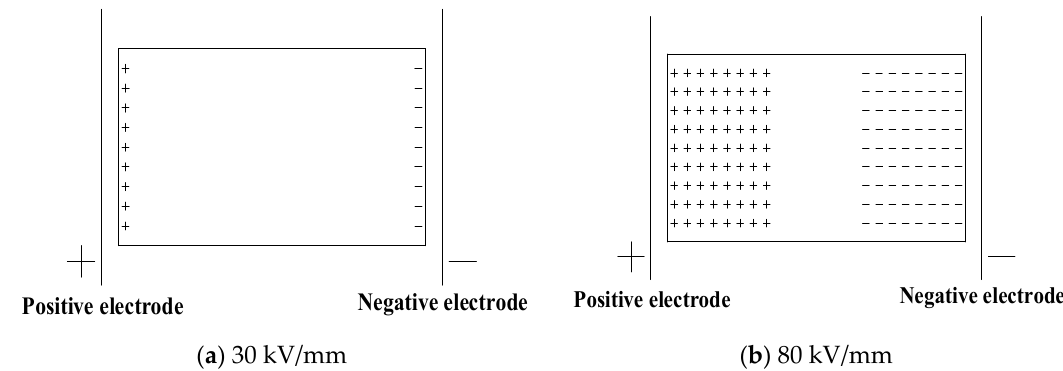
Figure 13. The situations of the charge injection and migration. ( a ) The schematic of charge injection and migration (30 kV/mm). ( b ) The schematic of charge injection and migration (80 kV/mm).